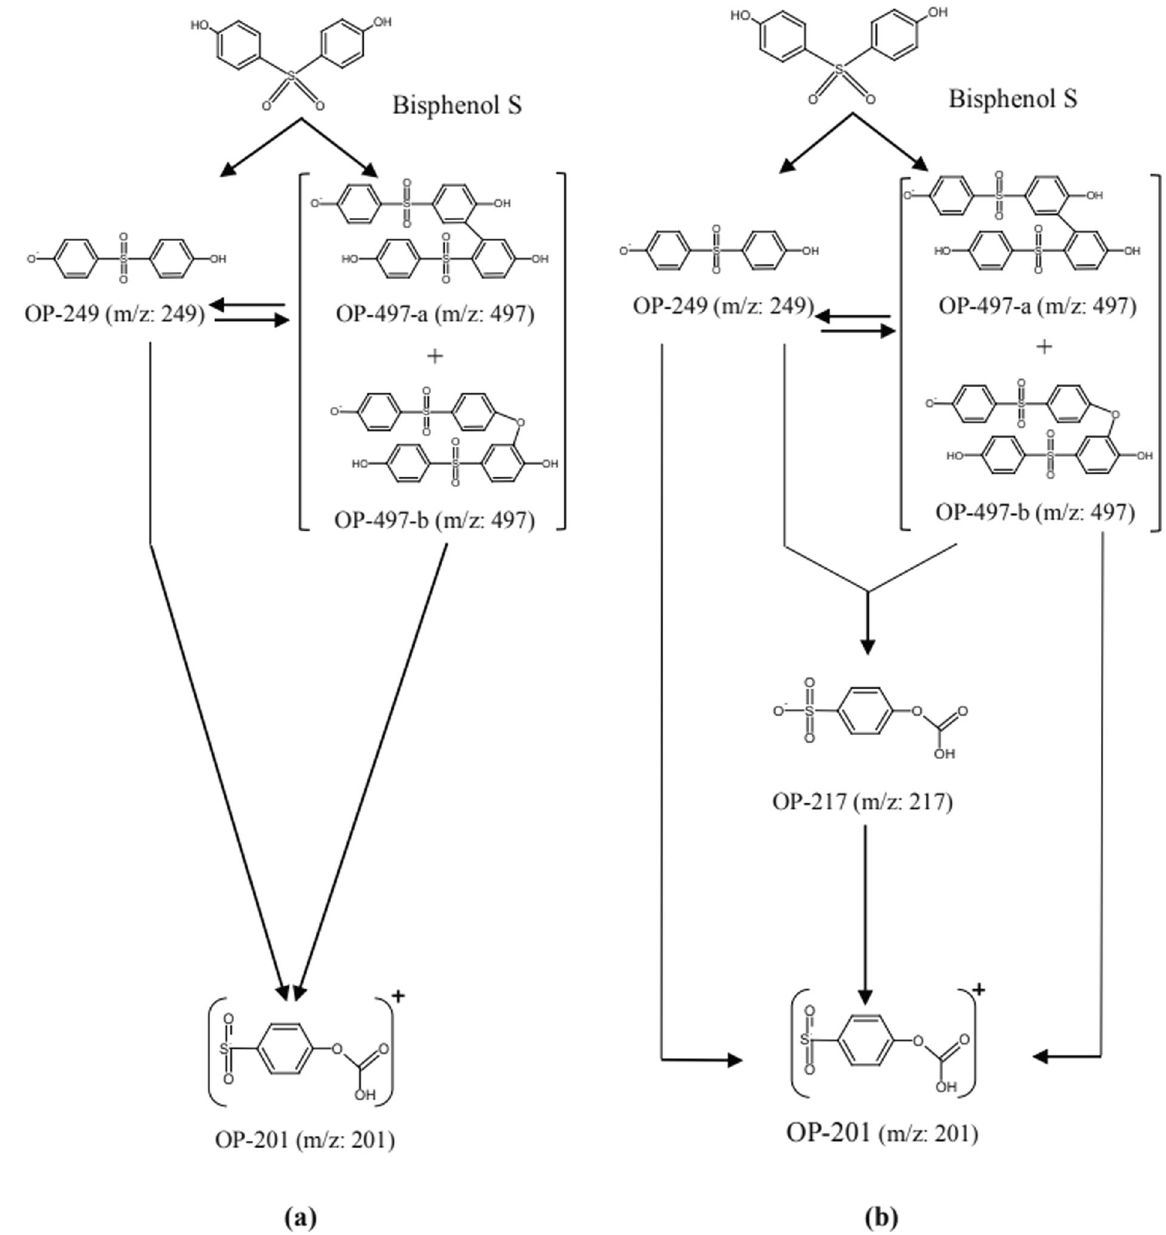
Fig. 3 BS degradation pathways. a Ozonation process and ( b ) ferrate